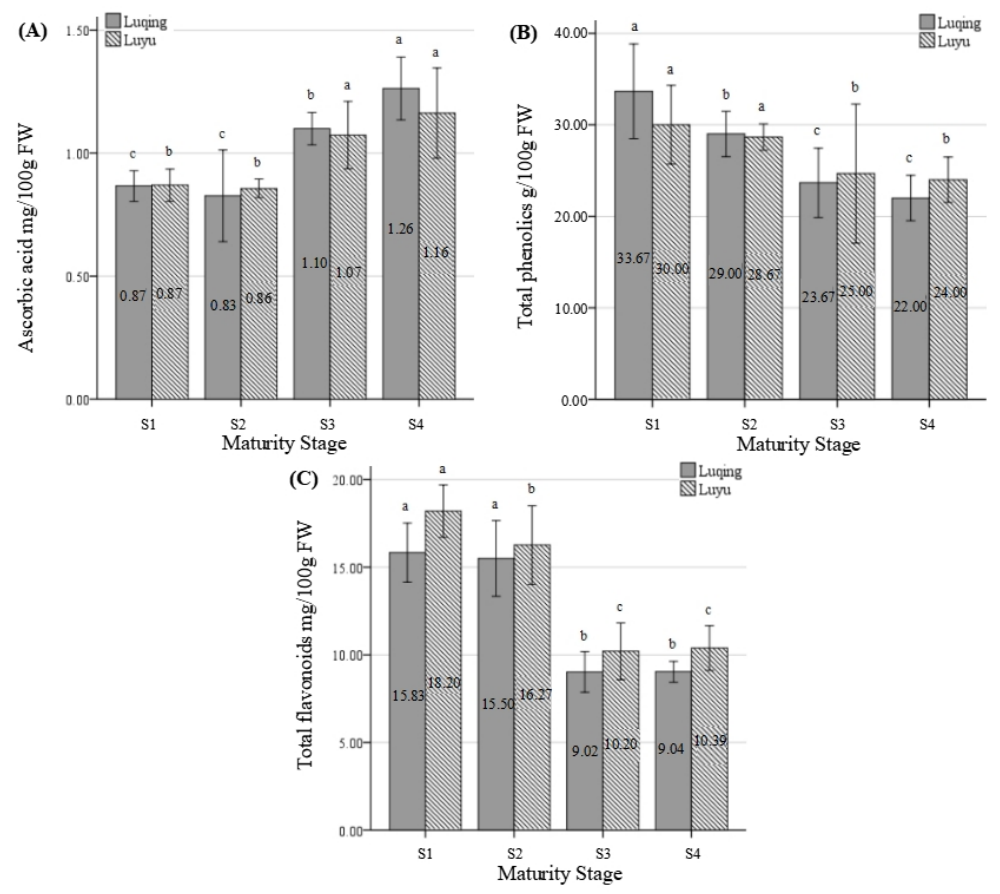
Figure 4. Ascorbic acid ( A ), total phenolics ( B ), and total flavonoids ( C ) contents in Akebia trifoliata fruit at four stages of ripening. Error bars indicate standard error from 3 replicates. Means with different letters within each clonal line indicate statistical differences at the p < 0.05 level using the LSD test. S1: 120 days after full bloom (DAFB), S2: 134 DAFB, S3: 148 DAFB, S4: 155